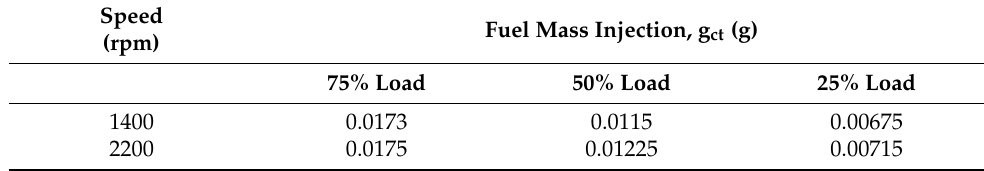
Table 7. Fuel injection at engine